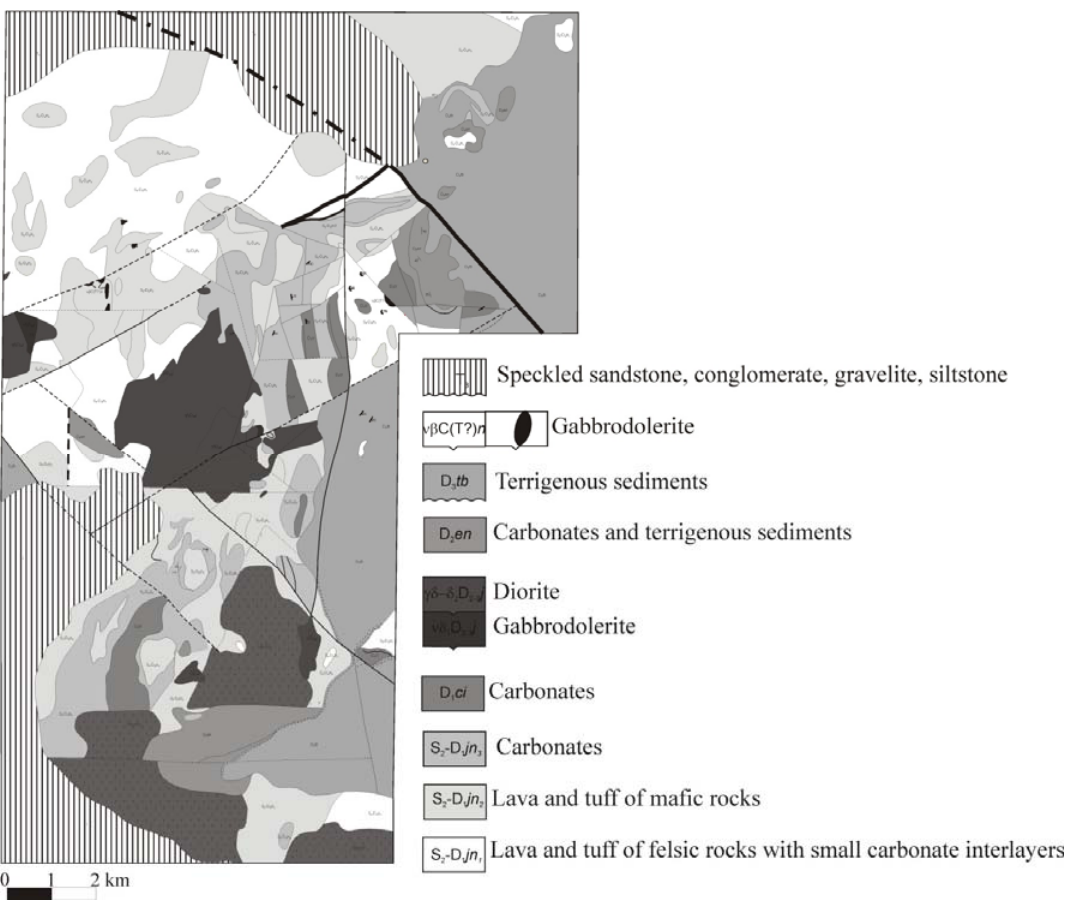
Figure 2. Lithology sketch ‐ map of the studied area.